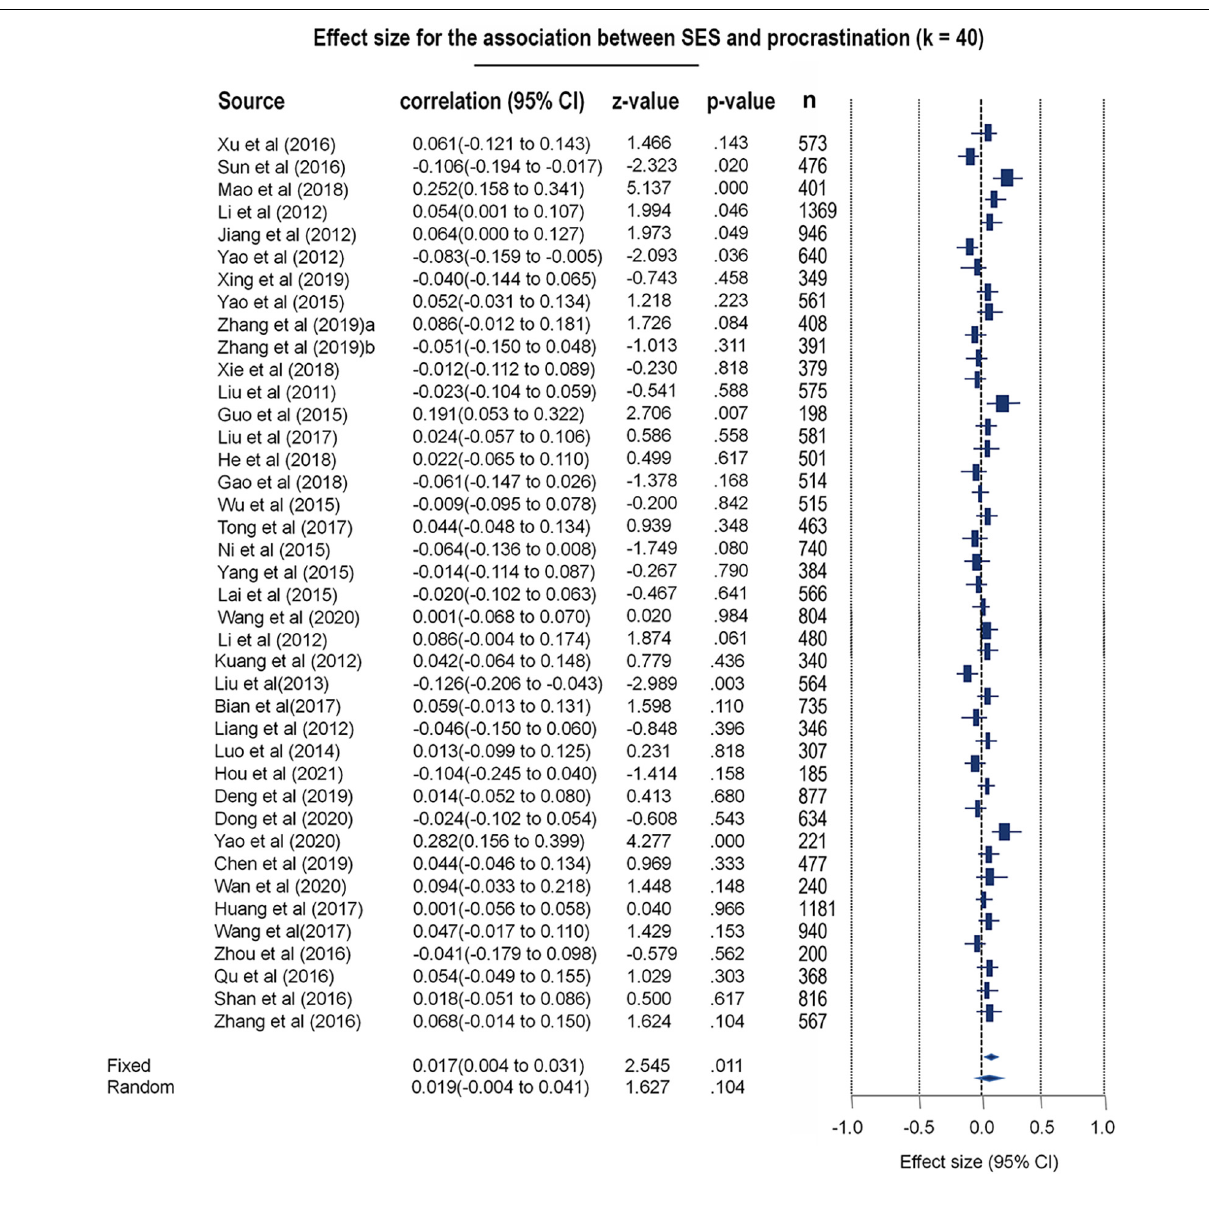
FIGURE 3 | Forest plot for the meta-analytic results toward socioeconomic status differences of